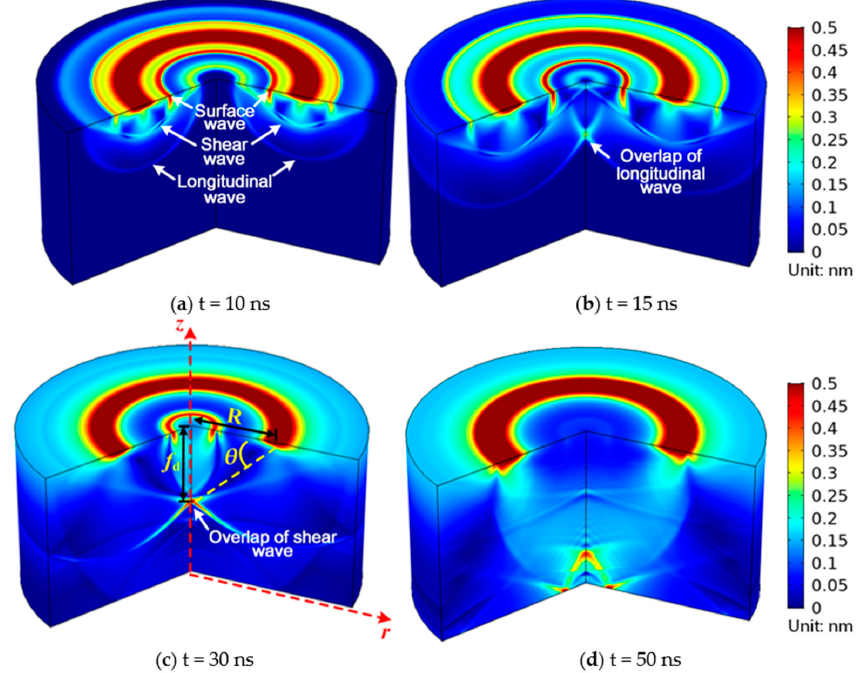
Figure 6. Cut plane view of the volumetric ultrasonic displacement field at different times: ( a ) before bulk waves overlap; ( b ) longitudinal waves overlap; ( c ) shear waves overlap; ( d ) after bulk waves overlap.